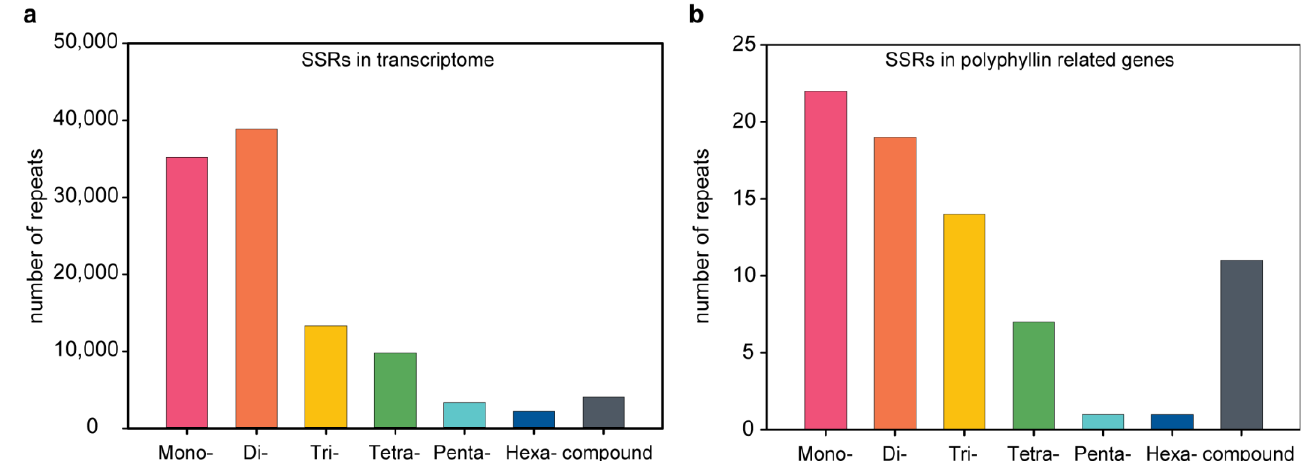
Figure 2. Statistics of EST-SSR based on the transcriptomic data. ( a ) number of different SSR types identified in the transcriptome: Mono-, Di-, Tri-, Tetra-, Penta-, Hexa-, and compound represent mononucleotide, dinucleotide, trinucleotide, pentanucleotide, hexanucleotide, and compound nu- cleotide, respectively; ( b ) number of different SSR related to polyphyllin biosynthesis.